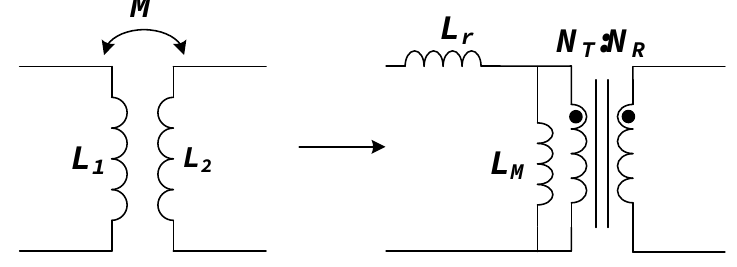
Figure 8. Equivalent transformer model for the WPC coils.